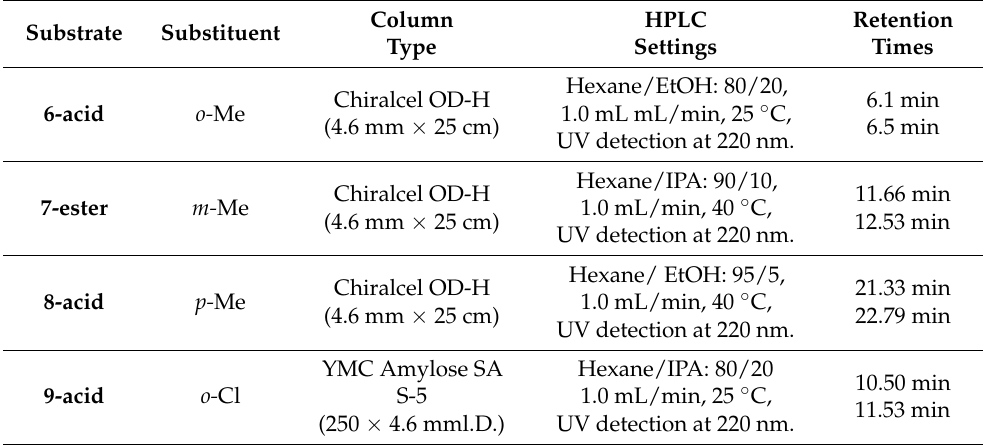
Table 6. Chiral HPLC conditions for determining the ee%’s of Pinder products (carboxylic acids) or their ester derivatives as